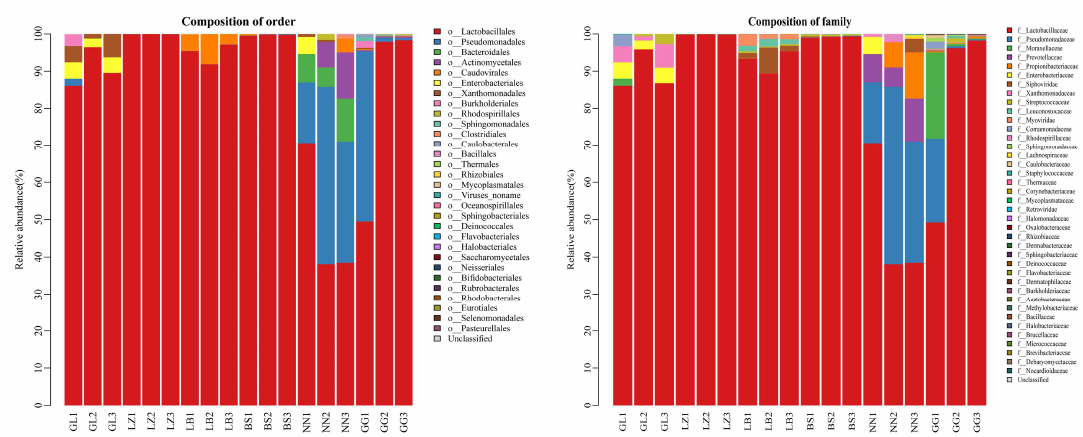
Figure 2. Order and family-level colony distribution map. GL, LZ, LB, BS, NN, GG represent Guilin, Liuzhou, Laibin, Baise, Nanning, and Guigang, respectively.